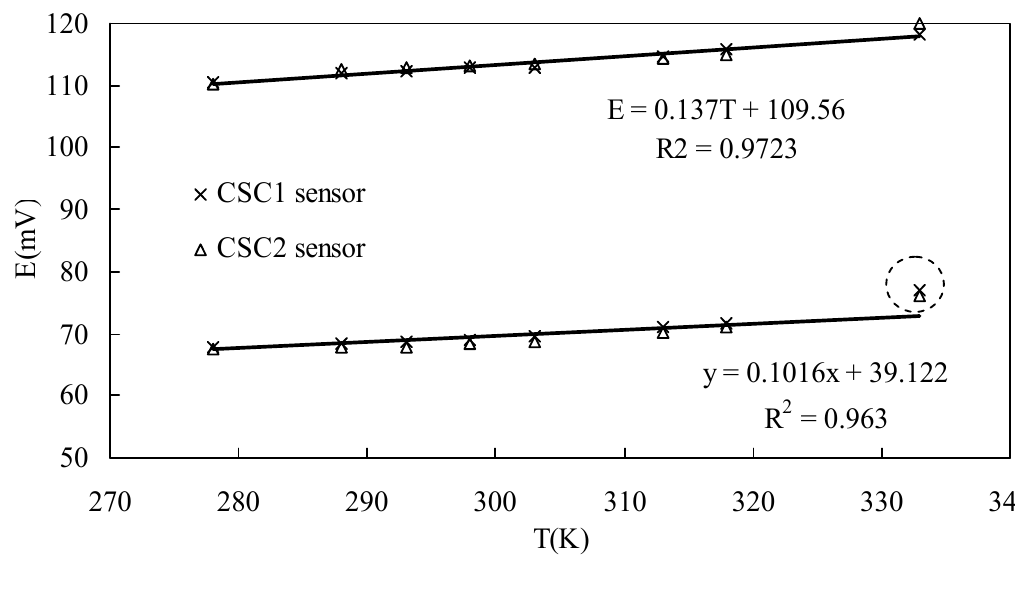
Figure 4. Influence of solution temperature on potentiometric response of the sensor to